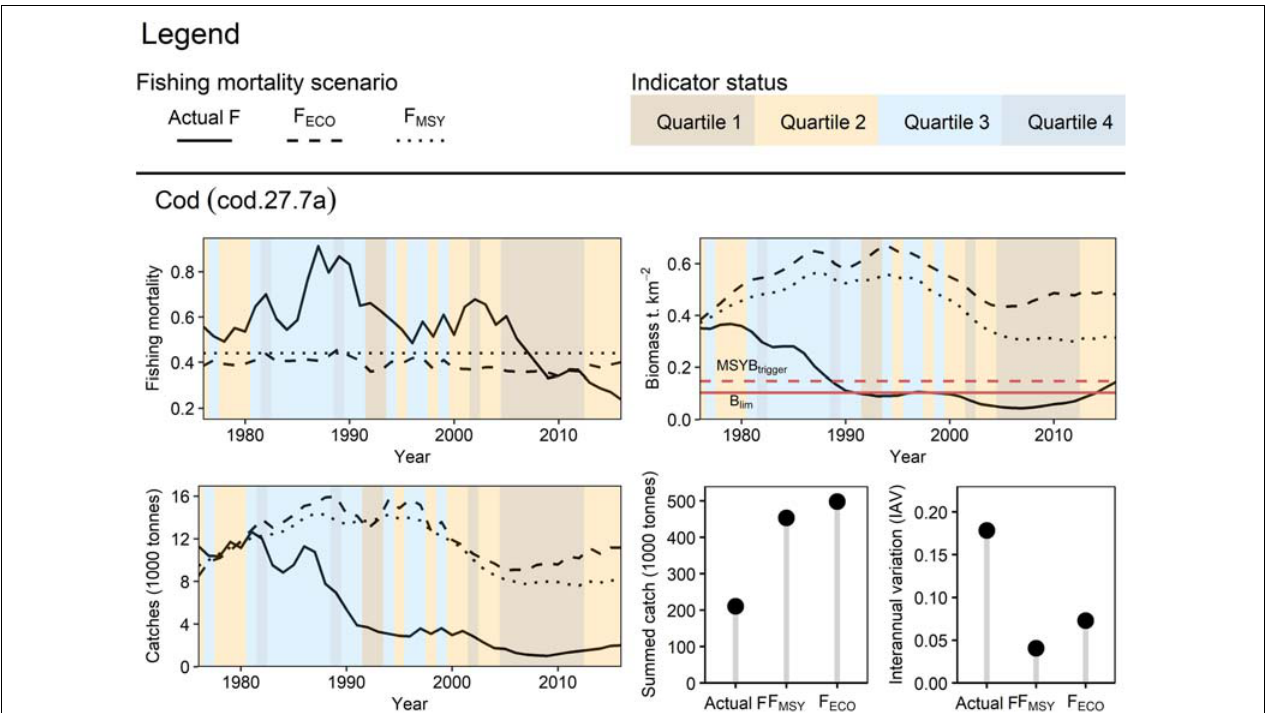
FIGURE 7 | Retrospective application of F ECO for Irish Sea cod: Three fishing mortality scenarios were prepared to simulate Irish Sea cod dynamics from 1976 to 2016. F ECO was retrospectively calculated based on the condition of the sea surface temperature (3-year lag) indicator. The different fishing mortality trends were applied to cod in the EwE model to simulate their effect on the stock’s biomass and catch (trend, total yield, and interannual